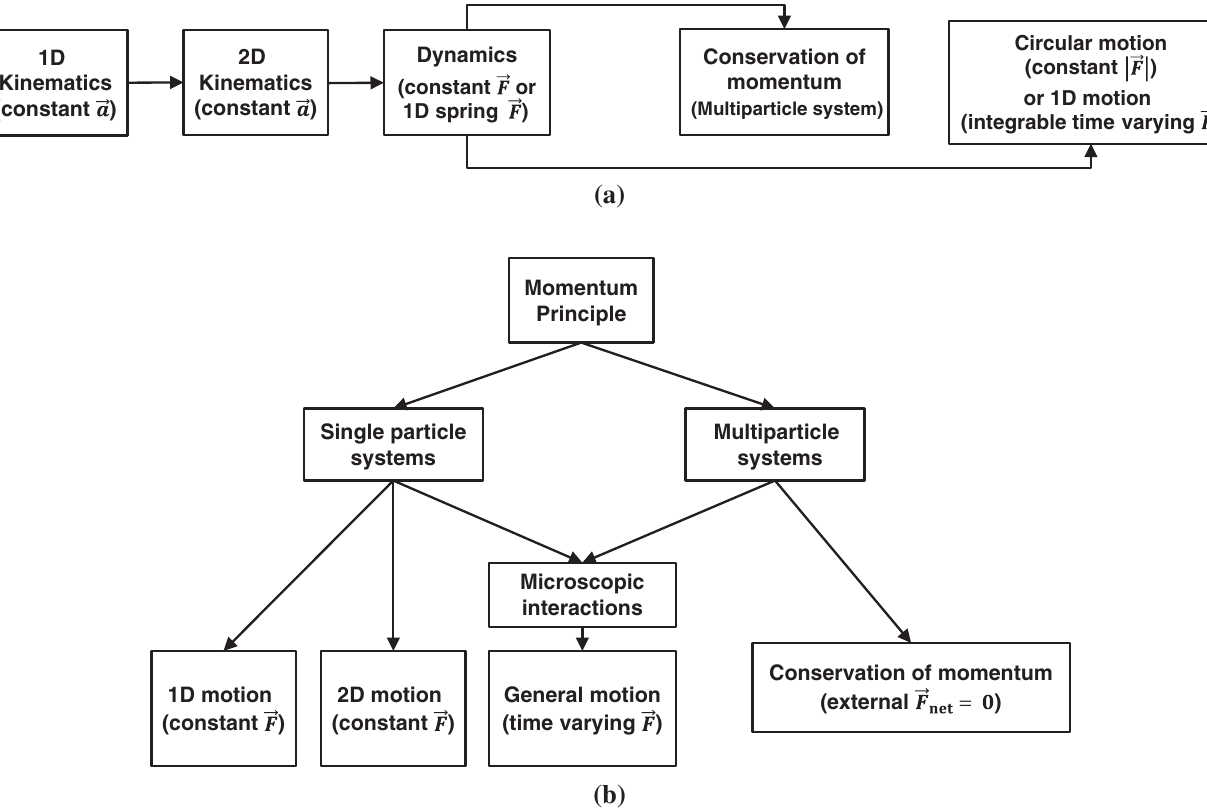
FIG. 1. The organizing structures of traditional mechanics courses and M&I modern mechanics. (a) The traditional canon of linearly sequenced force and motion concepts; arrows indicate the topical progression in traditional courses. (b) The hierarchical organization of force and motion concepts in M&I modern mechanics; arrows indicate the topical encapsulation from an overarching principle to specific